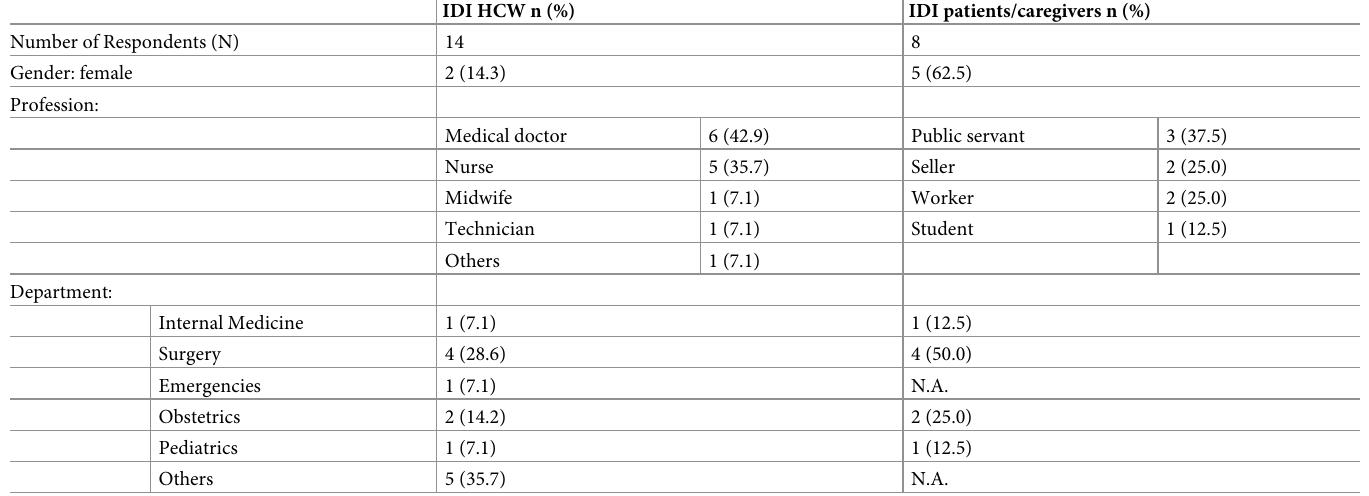
Table 2. Study population of